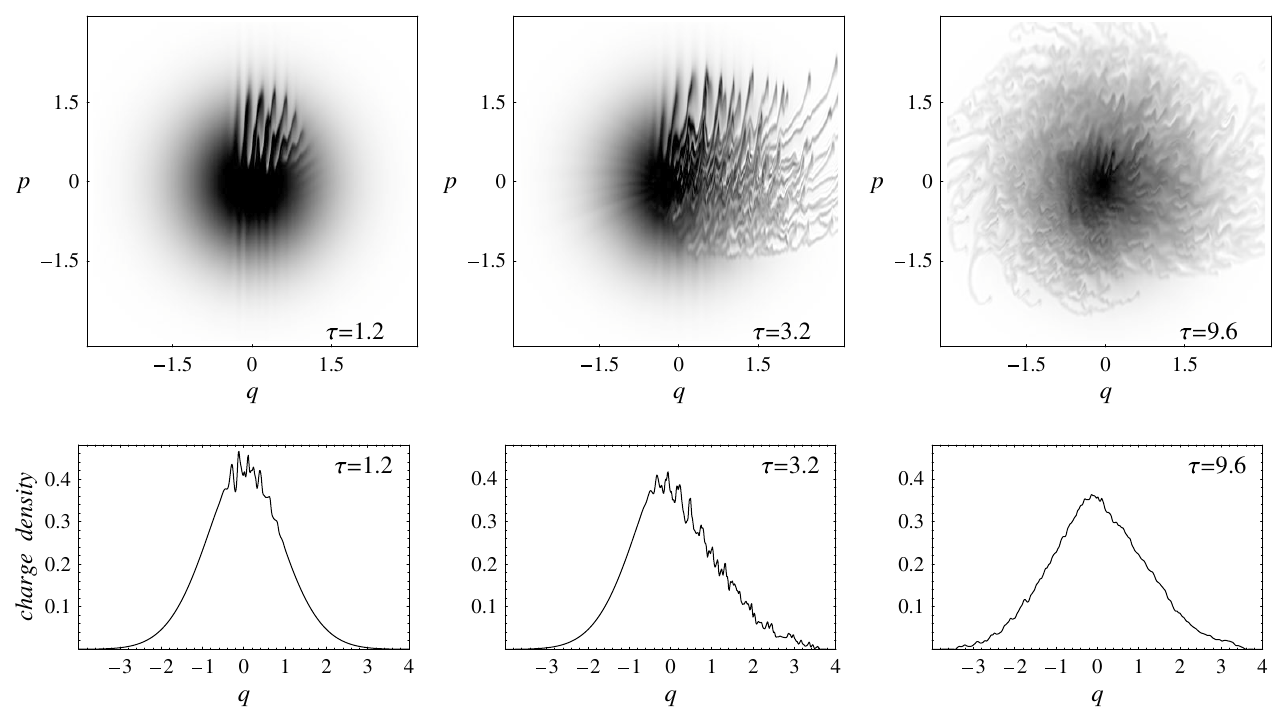
FIG. 7. Time evolution of bunch under effect of CSR. Density plots in phase space (top row) and charge density (second row). Pictures are taken at (normalized) time (cid:2) 1 : 2 , 3.2, and 9.6. Instability initiated by a small perturbation with mode number n (cid:2) 702 (wavelength (cid:4) (cid:2) 2 : 2 mm ). A unit of q corresponds to 1